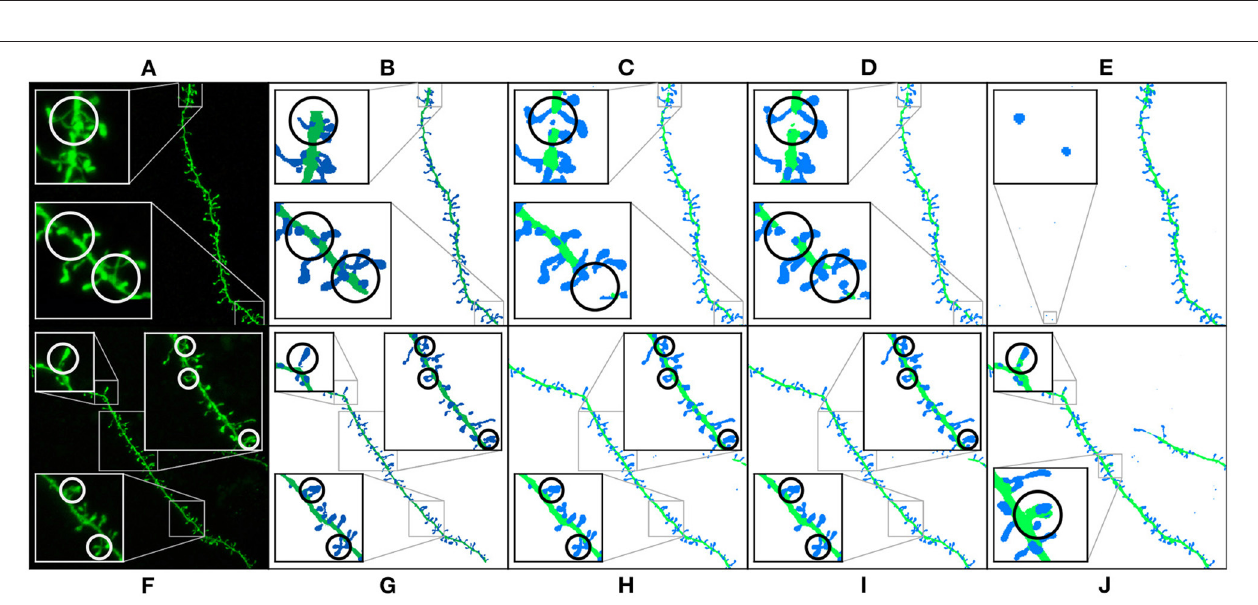
FIGURE 8 | GUI: (A) Organizes the users’ data hierarchically. (B–E) Provide a GUI to the postprocessing algorithms. (B) Shows the raw confocal image of the ROI. (C) Displays the output segmentation. (D) Allows the user to configure the algorithms, and (E) shows all the segmented structures.